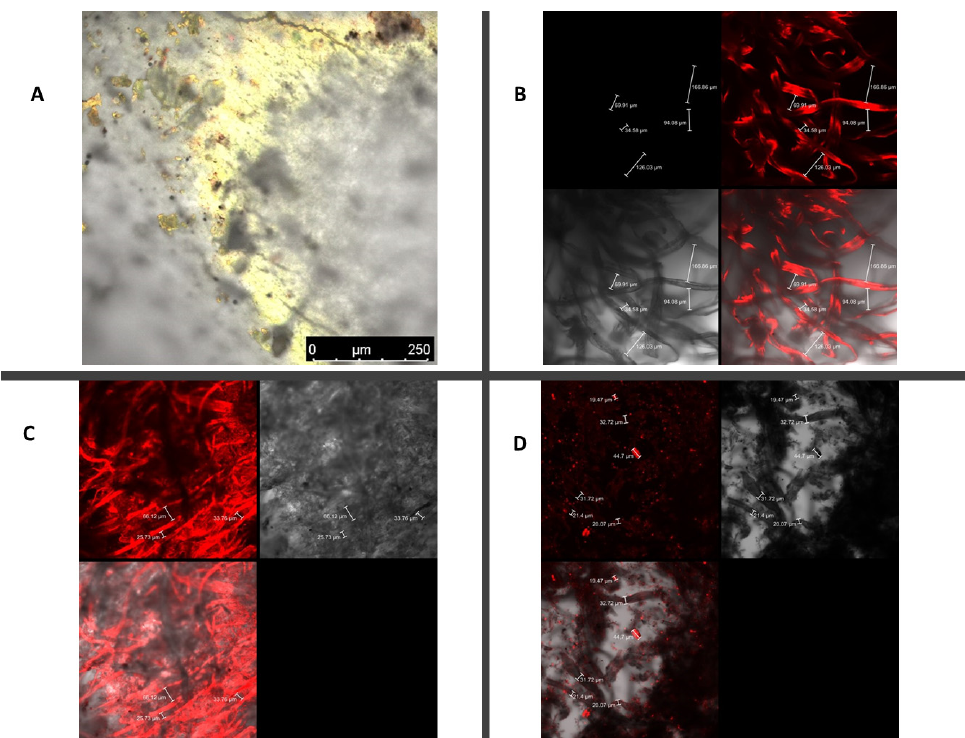
Figure 4. Confocal laser scanning microscopy images of ( A ) soybean peels, ( B ) diaper cellulose, ( C ) newspapers, ( D ) newspapers after treatment with H 3 PO 4 .